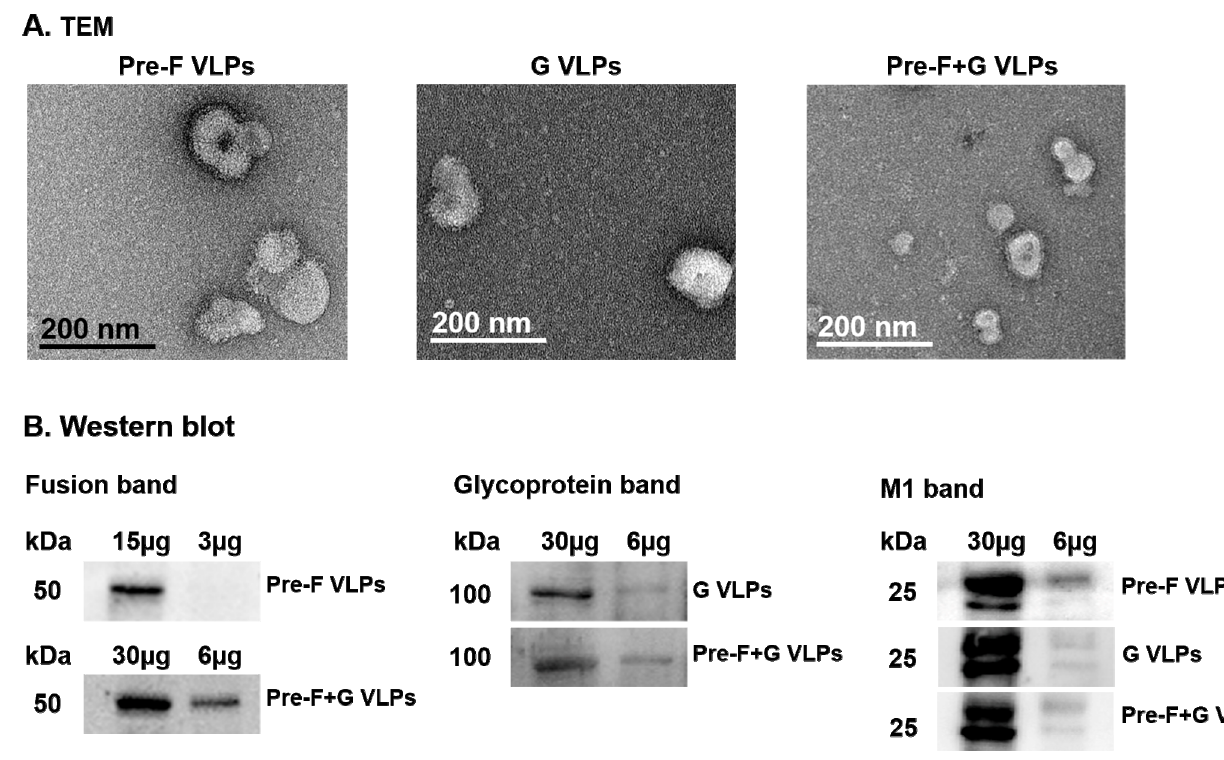
Figure 1. Characterization of the VLPs. VLPs expressing the RSV Pre-F, G, or both Pre-F and G antigens were visualized by transmission electron microscopy after negative staining ( A ). Influenza M1, RSV fusion, and glycoprotein antigen expressions on the VLPs were determined by Western blots ( B ).